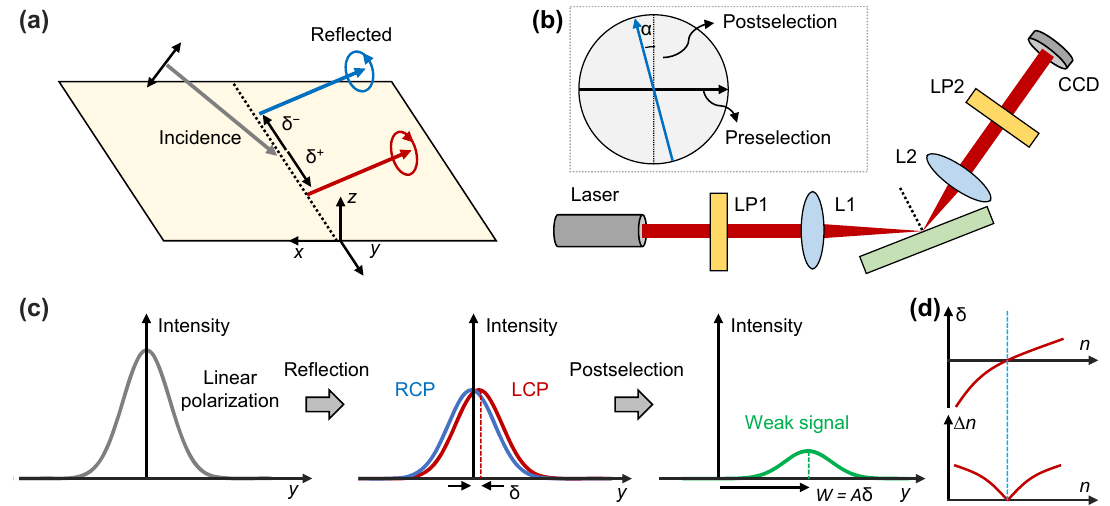
Figure 1: Spin Hall effect of light (SHEL) and its implementation for high-precision measurement. (a) Schematic of the SHEL. (b) Weak measurement setup. Inset: polarizations of preselection and postselection states. (c) Beam intensity profiles of the incident, reflected, and postselected beams along the transverse axis. LP, linear polarization; L, lens; CCD, charge-coupled device. (d) Illustration of 𝛿 and Δ n when 𝛿 crosses